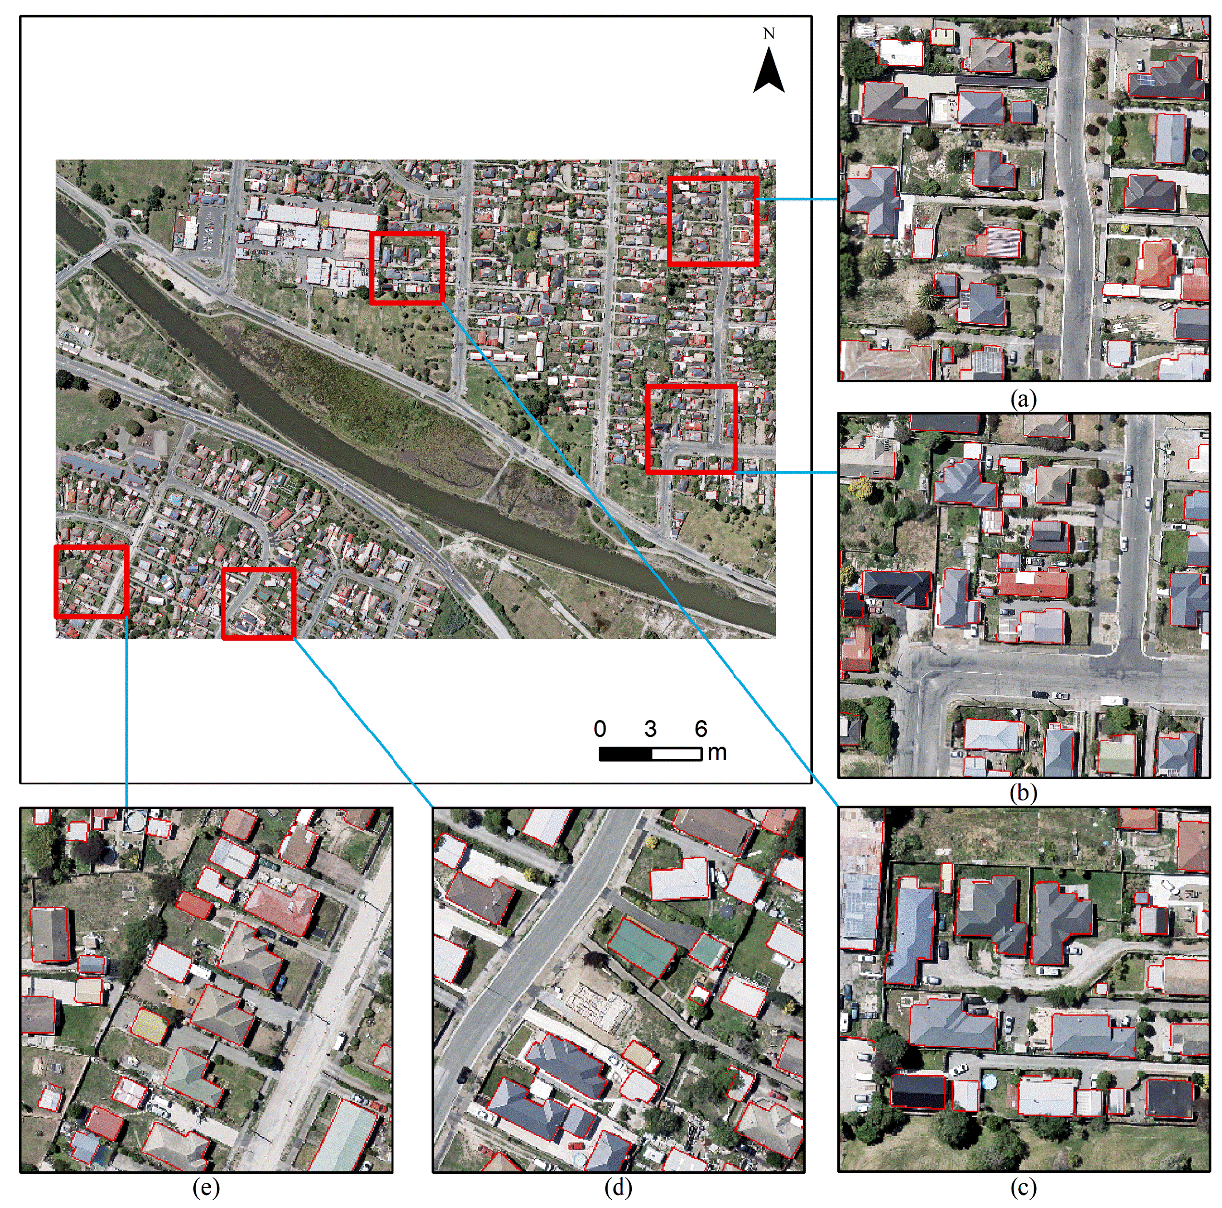
Figure 11. Image-to-image prediction results on the WHU dataset ( a – e